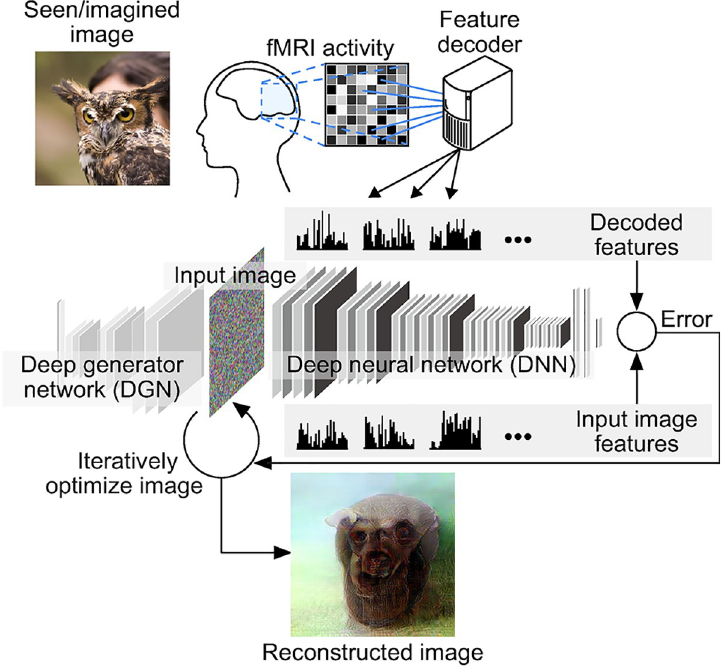
Fig 1. Deep image reconstruction. An overview of a deep image reconstruction is shown. The pixel values of the input image are optimized so that the DNN features of the image are similar to those decoded from fMRI activity. A deep generator network (DGN) is optionally combined with the DNN to produce natural-looking images, in which optimization is performed at the input space of the DGN.